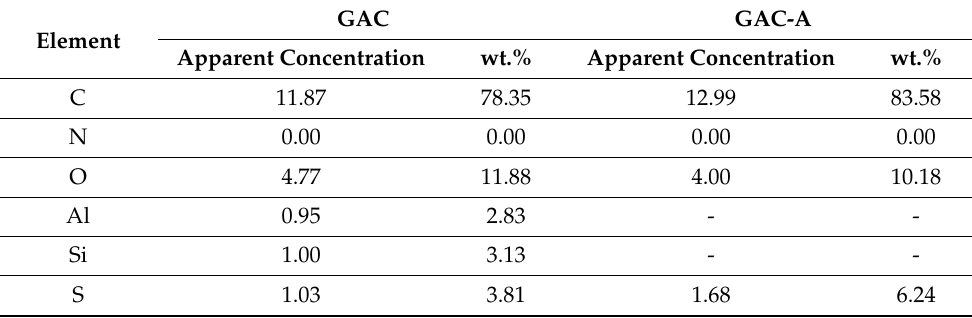
Table 2. Brunauer–Emmett–Teller (BET) analysis results of activated carbon. BET Surface Area Adsorbent